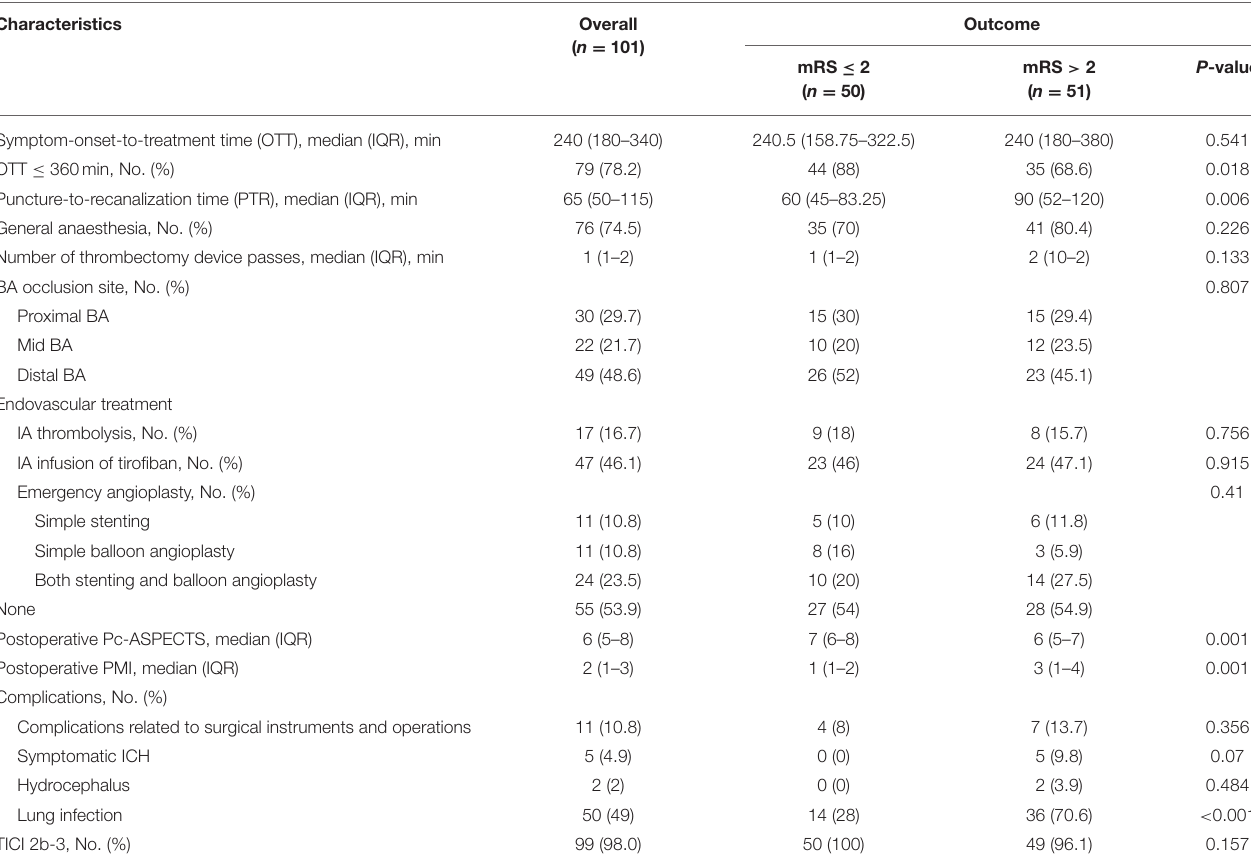
TABLE 3 | Periprocedural characteristics and functional outcome (mRS ≤ 2 vs. mRS score > 2).